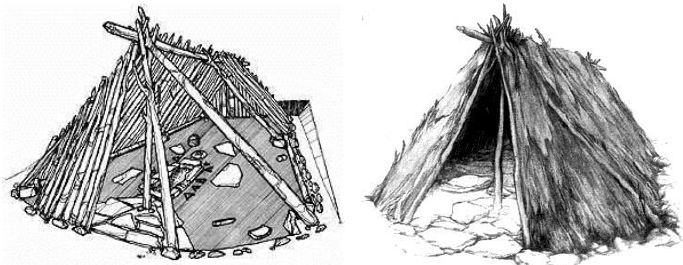
Figure 24. Two similar reconstructions of the house in Lepenski Vir